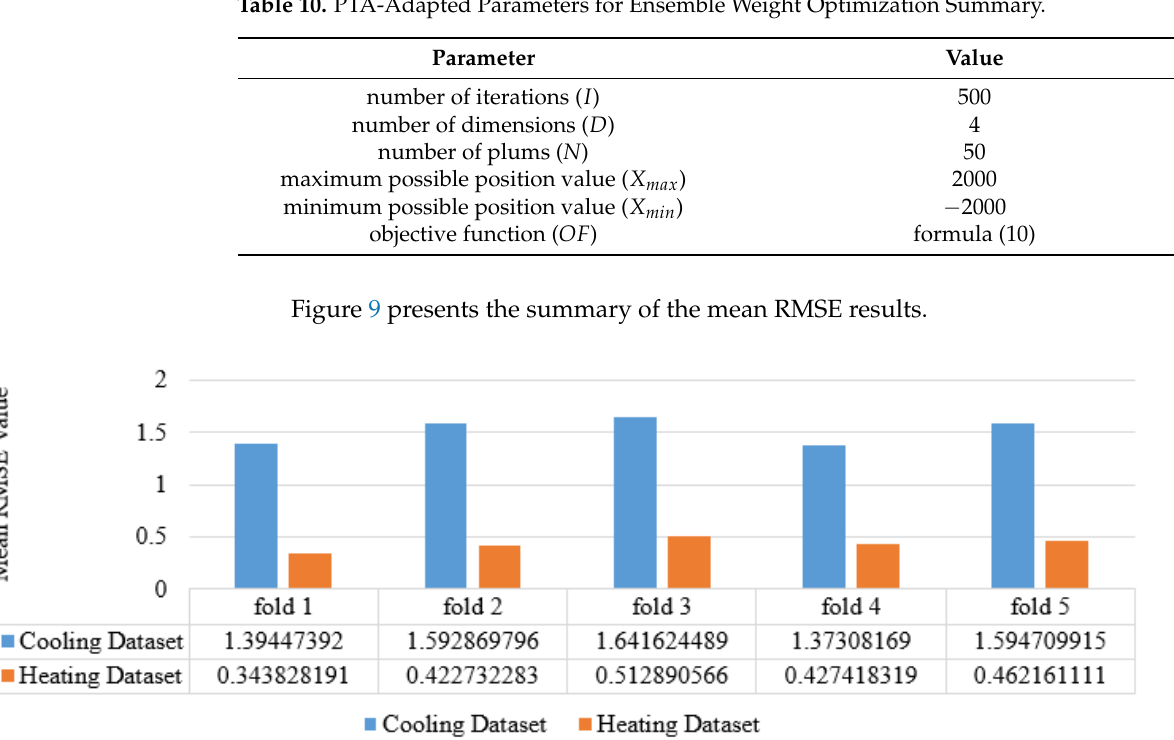
Figure 9. PTA Ensemble Mean RMSE Results Summary.